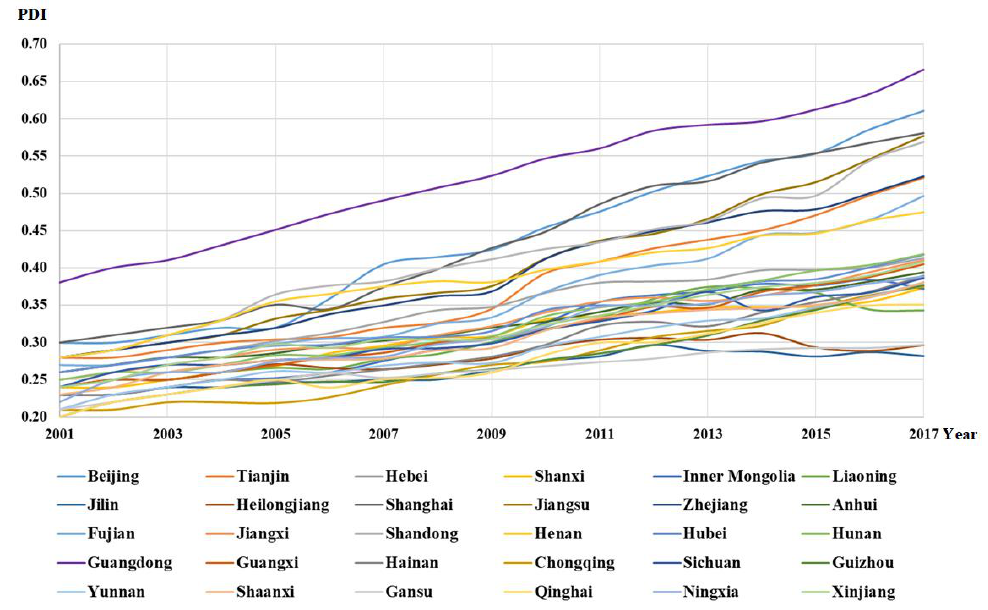
Figure 2. The PDI changes in 30 provinces from 2001 to 2017. Jilin, Heilongjiang and Gansu are at the bottom of the PDI list. Although continuous population urbanization is occurring in Jilin and Heilongjiang, the geographical location and climate problems of these two provinces have led to a large population outflow. In addition, the natural population growth rate is low, the population scale is on the decline and the elderly population continues to grow, which is not conducive to the long-term population and regional development. There is limited per capita wealth and an aging population, which are common characteristics of these three provinces. For these prov- inces, it is important to formulate relevant population policies to promote population in- flow, reduce the proportion of the aging population and give full play to the dividend of population agglomeration so as to promote long-term population development. The average PDI in the 30 provinces increases over time, while regional disparities are also reflected in the PDI, similar to how Table 4 shows, which contained the statistical information of the PDI. In 2001, Guangdong Province showed the optimal PDI of 0.38, while Guizhou and Qinghai had the lowest PDI, which is only 0.20, lower than the na- tional average of 0.25. In 2017, the optimal PDI reached 0.67, while the lowest PDI was 0.28. The individual gap between the optimal PDI and the worst gradually widens each year in the sample period, indicating a huge development gap. Although the PDI in Hebei, Shanxi, Inner Mongolia, Anhui, Jiangxi, Hubei, Hunan, Guangxi, Hainan, Chongqing,